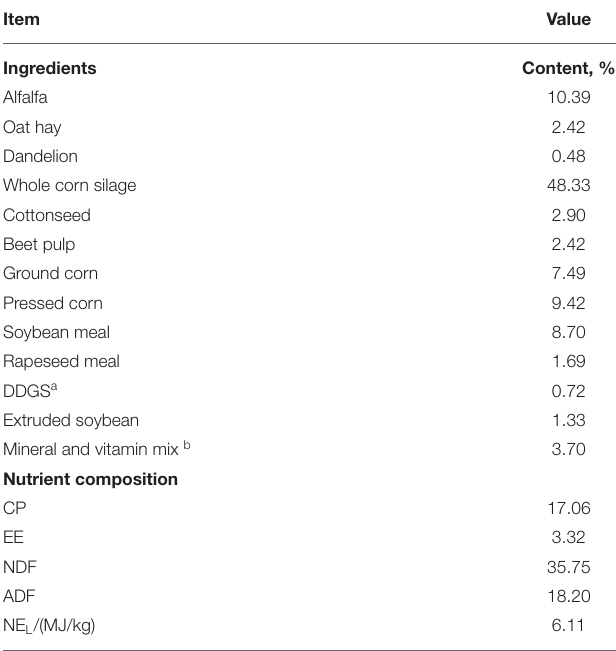
TABLE 1 | Ingredients and nutrient composition of experimental diets (% Air-dry